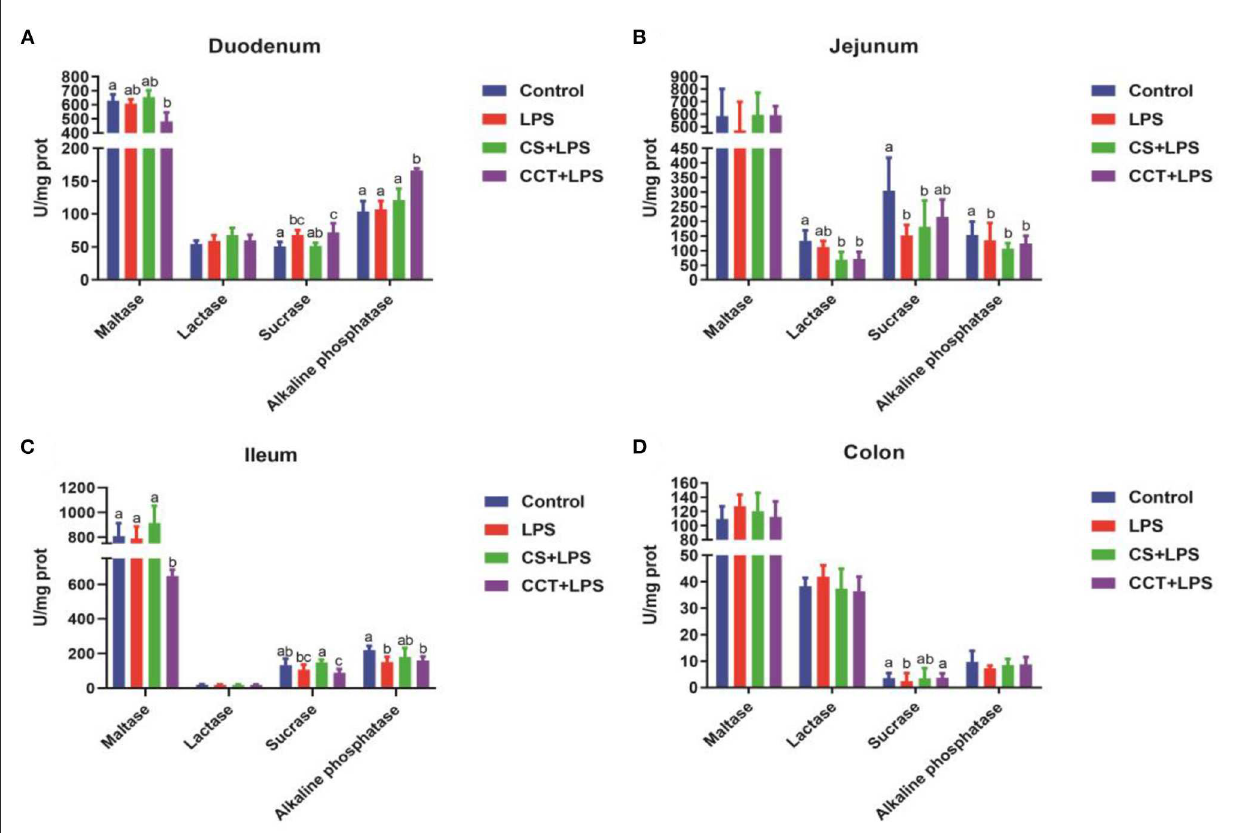
FIGURE1 Effects of CCT and CS supplementation on the activities of intestinal disaccharidases in LPS-challenged piglets. The activities of maltase ( p = 0.062), lactase ( p = 0.882), sucrase ( p = 0.004) and alkaline phosphatase ( p = 0.006) in duodenum (A) , the activities of maltase ( p = 0.440), lactase ( p = 0.002), sucrase ( p = 0.003) and alkaline phosphatase ( p = 0.006) in jejunum (B) , the activities of maltase ( p = 0.002), lactase ( p = 0.922), sucrase ( p = 0.005) and alkaline phosphatase ( p = 0.010) in ileum (C) , and the activities of maltase ( p = 0.741), lactase ( p = 0.418), sucrase ( p = 0.099) and alkaline phosphatase ( p = 0.417) in colon (D) in LPS-challenged piglets. Data are means ± SD, n = 6, CS, colistin sulfate; CCT, a complex of cinnamaldehyde, carvacrol and thymol. Differences among treatment means were determined using Duncan’s post-hoc tests. a − c Means within rows with different superscripts different ( P <